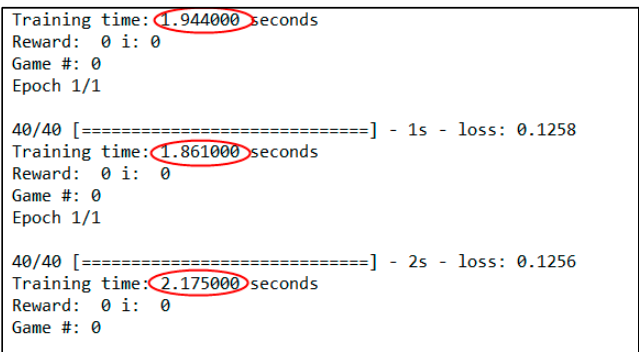
Figure 10. Training Time using a Central Processing Unit (CPU).